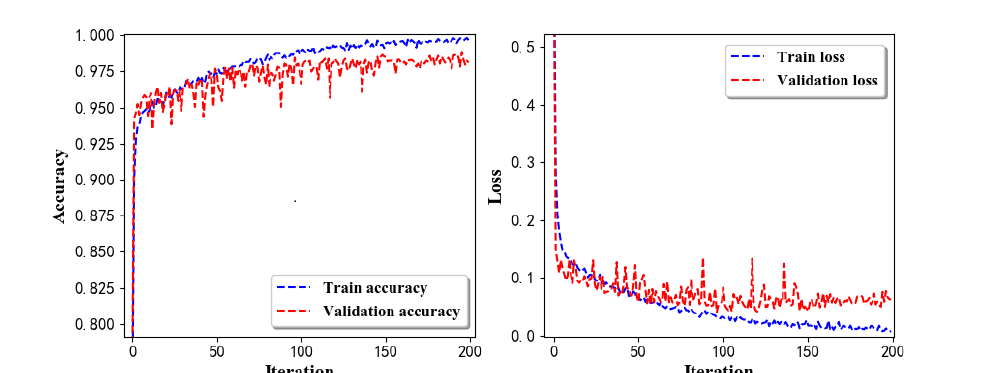
Figure 9. Accuracy ( left ) and loss ( right ) information of training and validation